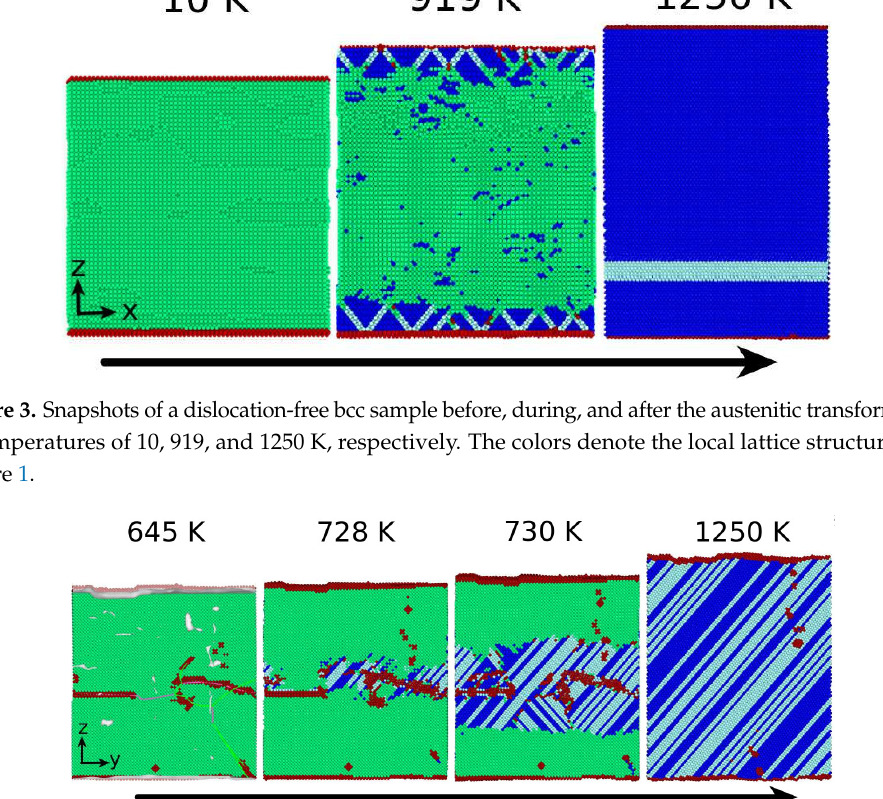
Figure 4. Snapshots of a bcc sample with low dislocation density, ρ = 1.72 × 10 12 cm − 2 , before, at the start, during, and after the austenitic transformation at temperatures of 645, 728, 730, and 1250 K, respectively. The colors denote the local lattice structure as in Figure